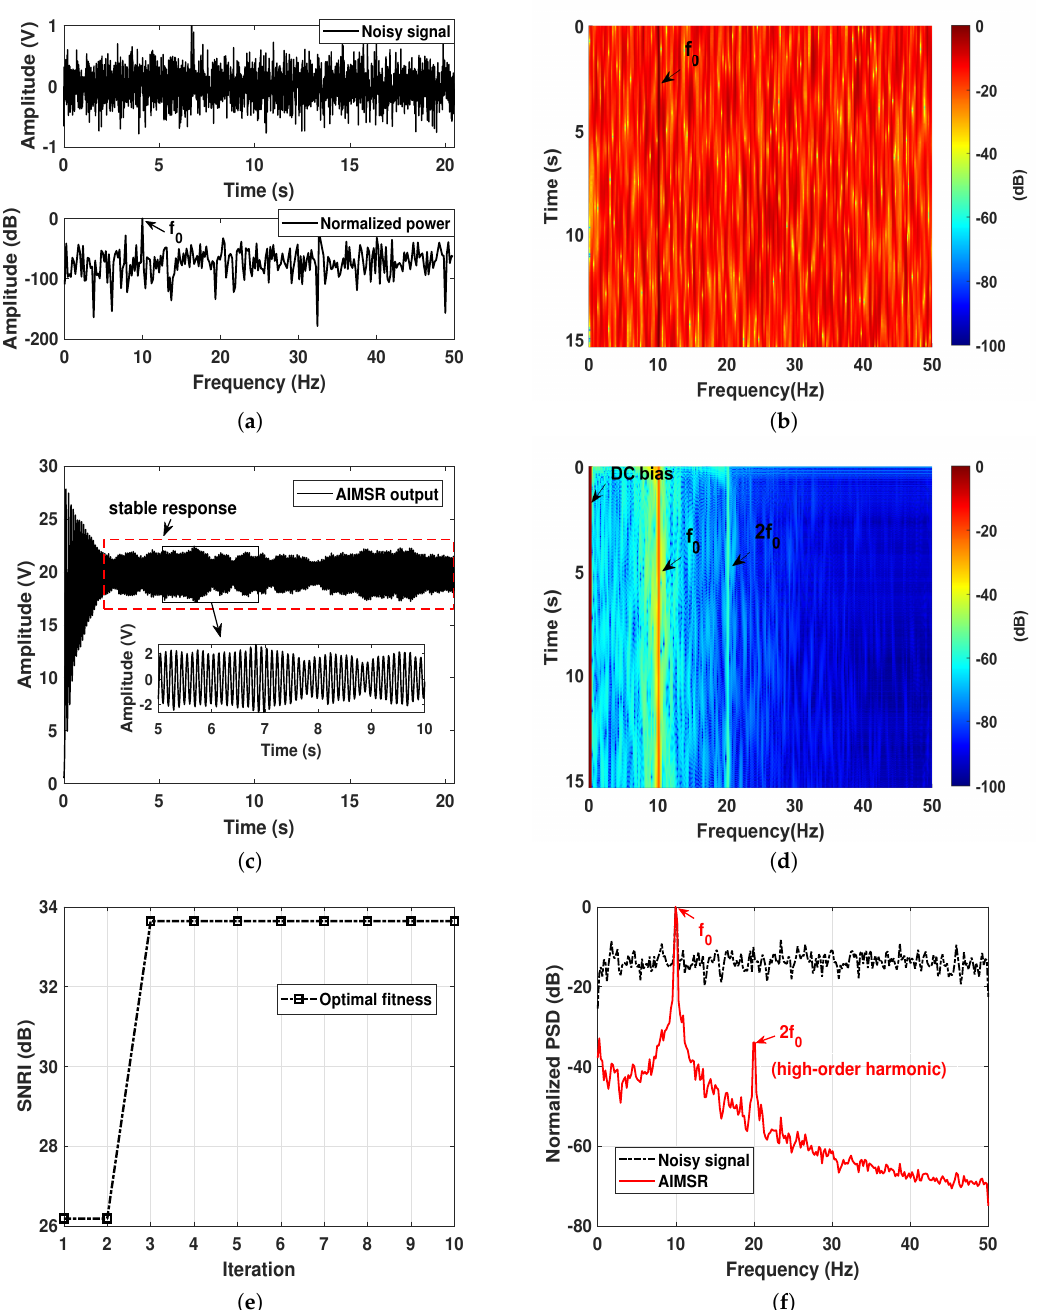
Figure 2. A simulation of discrete line signature signal on H 1 assumption: ( a ) the input waveform and its normalized power spectrum; ( b ) lofargram obtained with the input; ( c ) the adaptive intrawell matched stochastic resonance (AIMSR) output waveform ( γ opt = 0.0322, K opt = 79.05, h opt = 0.4413); ( d ) lofargram obtained with the AIMSR output; ( e ) the optimal fitness at each iteration with genetic algorithm (GA) method; ( f ) filtering performance comparison with normalized power spectrum density (PSD, Welch